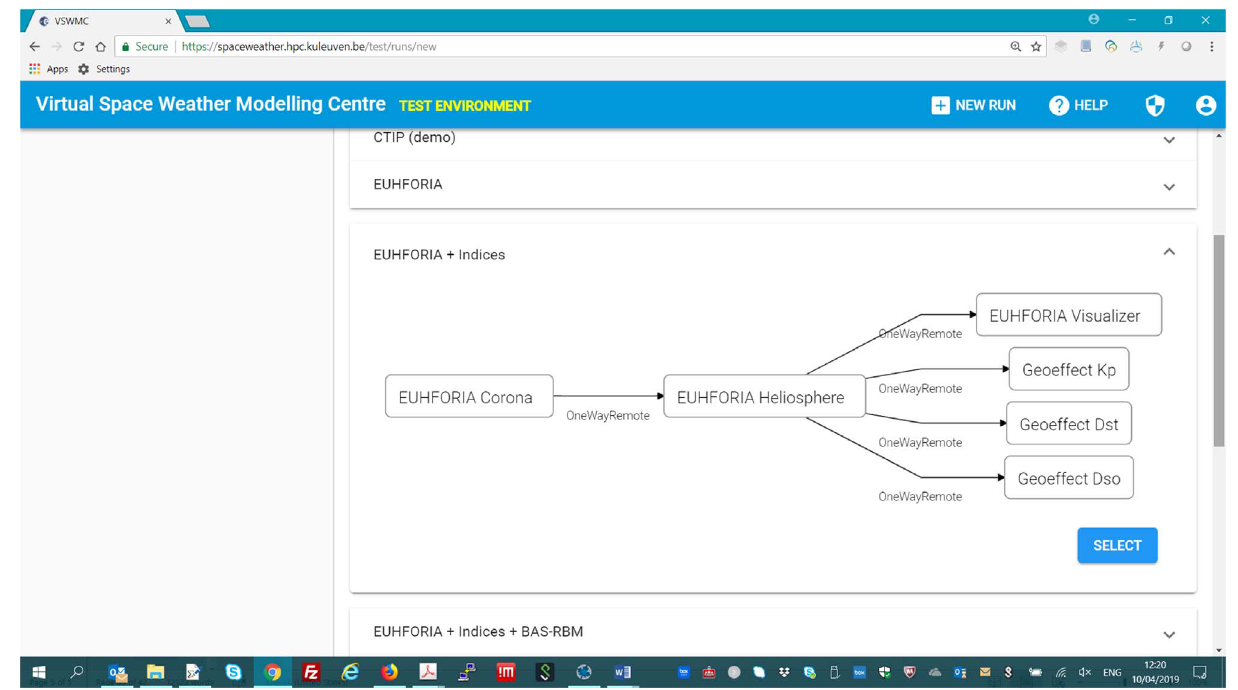
Fig. 8. The EUHFORIA + indices model